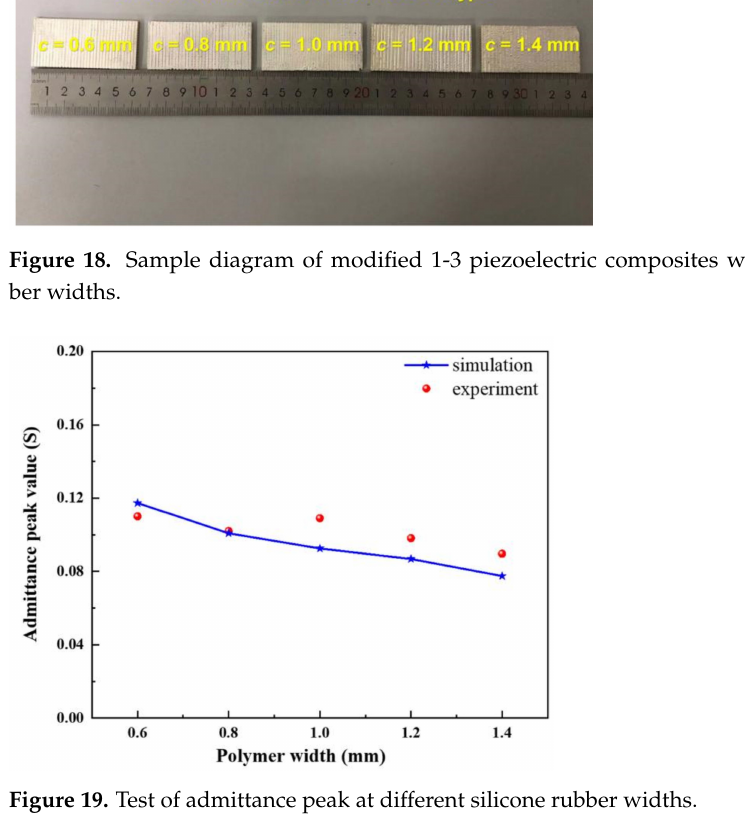
Figure 19. Test of admittance peak at different silicone rubber